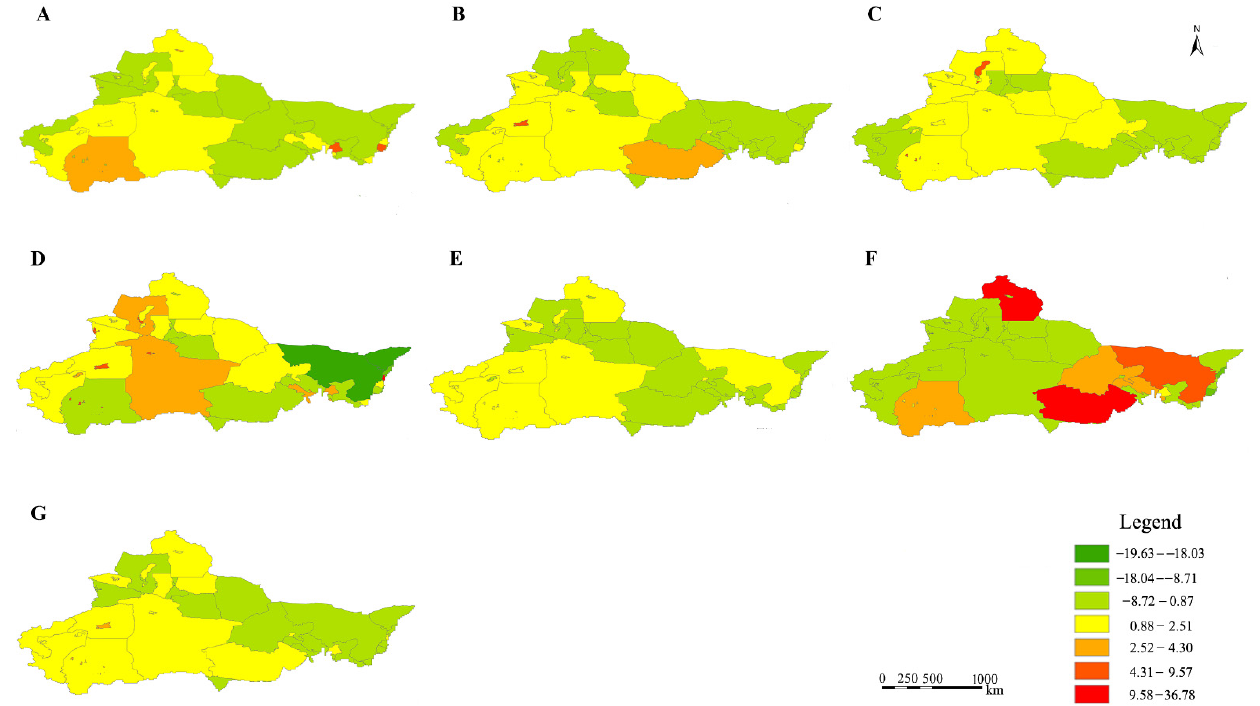
Figure 2. Relative dynamic degree of cultivated lands in the arid desert region of Northwest